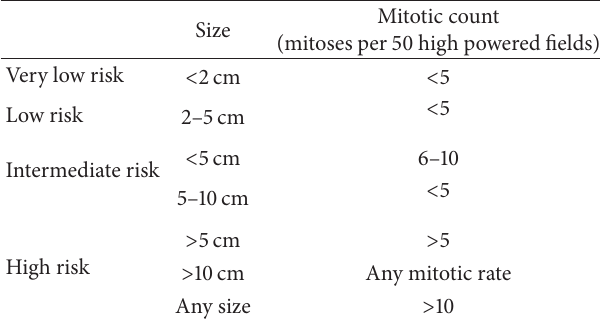
Table 1: Risk of aggressive behaviour in GISTs (adapted from Fletcher et al., 2002)